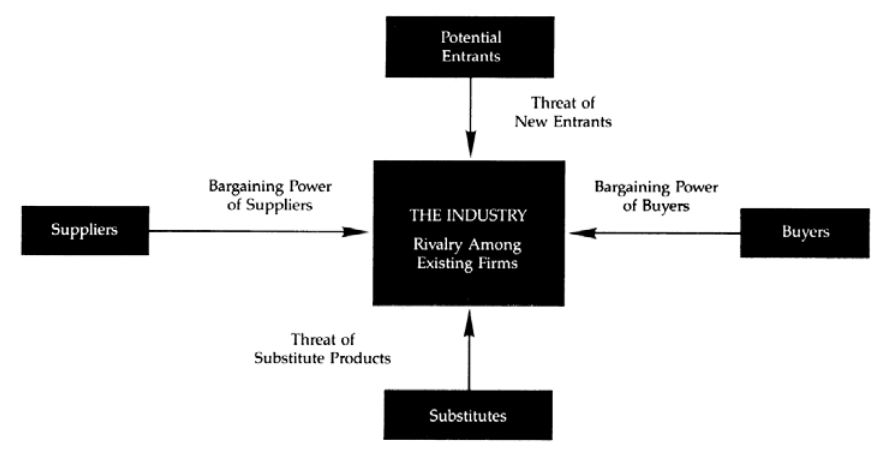
FIGURE 1: The five forces driving industry competition Source: Porter